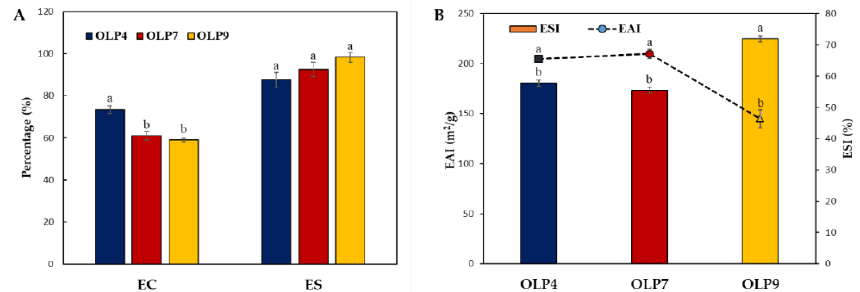
Figure 3. Emulsifying properties of polysaccharides from okra leaves (OLPs). Centrifugal ( A ) and turbidimetric ( B ) estimation of emulsifying activity (EC and EAI) and stability (ES and ESI). a,b Superscripts represent significant differences (Tukey’s test, p < 0.05).